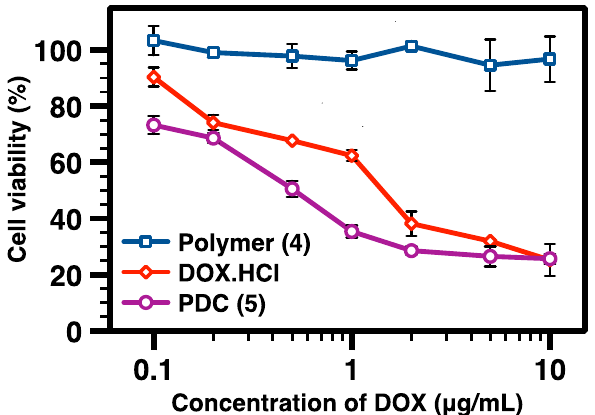
Figure 8. Cytotoxicity of PEG- b -PCL- g -ALD polymer ( 4 ), DOX · HCl, and PEG- b -PCL- g -DOX PDC ( 5 ) against MCF-7 cells after 24 h incubation. Each data point with error bars represents the mean value ± the standard deviation obtained from three independent measurements. Polymer ( 4 ) was used as the same molar concentration of PDC ( 5